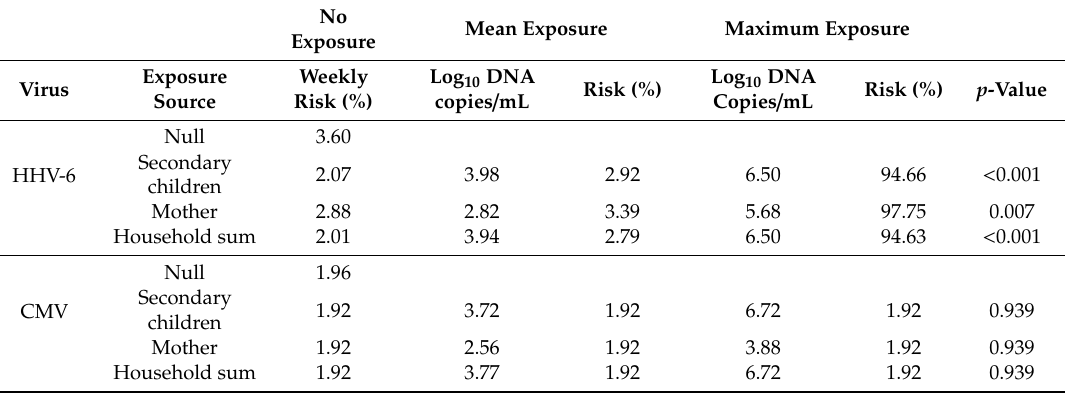
Table 1. Estimates of the weekly risk for each virus with no exposure (constant weekly risk) and by exposure source. Models of risk were fit without exposure (null model) and independently for each exposure source. Weekly risk with exposure includes constant risk from the model. The mean exposure was calculated among positive swabs. The P-values were calculated from the model to test if risk attributable to exposure is significantly di ff erent from null model without exposure risk (log-likelihood ratio